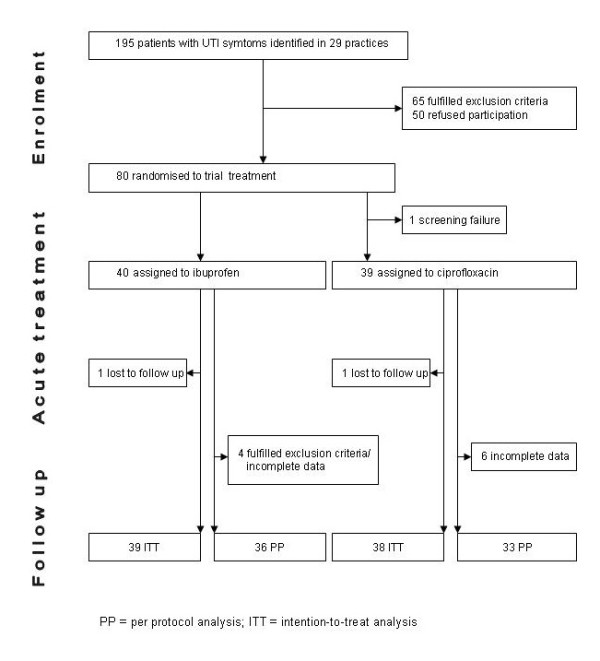
Participant flow.